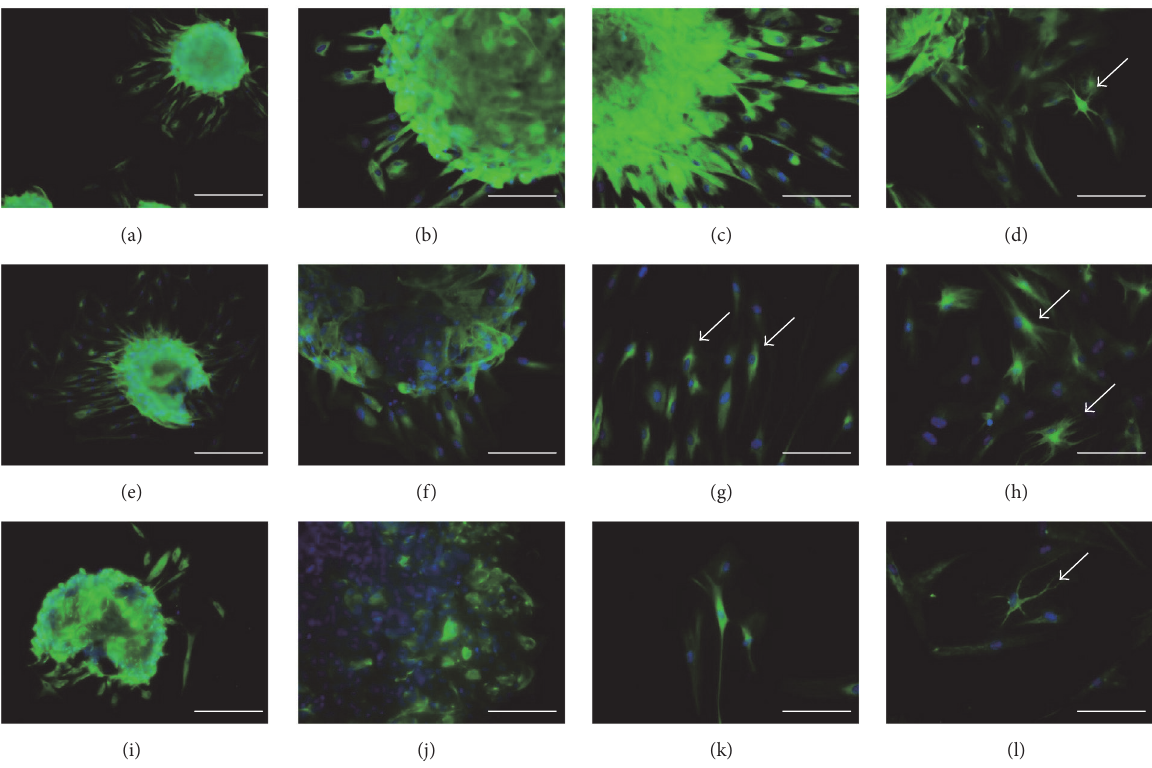
Figure 5: Immunofluorescence staining for neural markers in hDFCs following two-step neuronal induction. (a – d) Nestin staining. (e–h) 𝛽 -III-Tubulin staining. (i – l) S100 𝛽 staining. (a, b, e, f, i, j) A neurosphere cultured in NDM on day 0. (c, g, k) The cells in the neurosphere cultured in NDM on day 3 grew out from the sphere. (d, h, l) The cells in the neurosphere cultured in NDM on day 7 grew out from the sphere. Scale bars (a, e, i) = 100 𝜇 m and (b, c, d, f, g, h, j, k, l) = 50 𝜇 m. Arrows indicate cells that were strongly positive for the marker and that showed neural-like morphology with branched dendrites and refractile cell